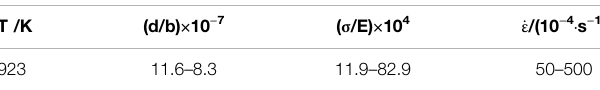
TABLE 2 | Calculated results of Ti-6Al-4V alloy after superplastic tensile